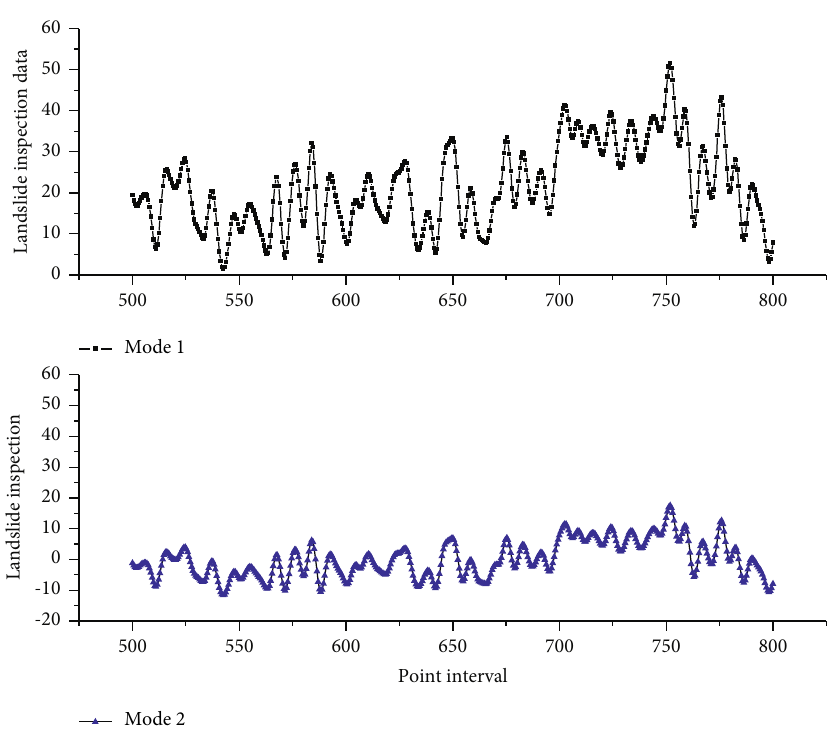
Figure 6: Data distribution of landslide inspection parameters.